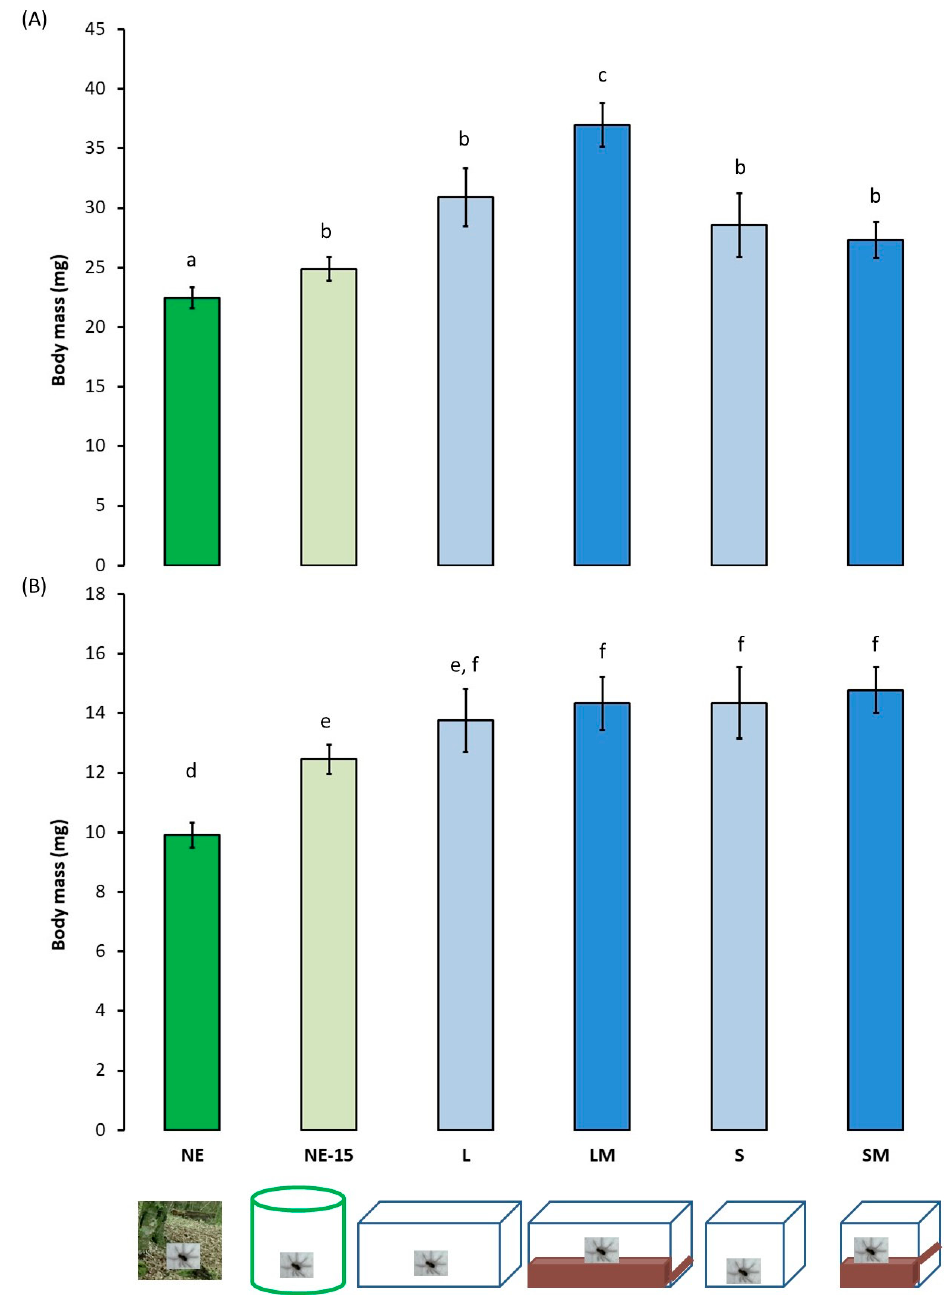
Figure 3. Body mass ±95% confidence intervals (in mg) of adult female ( A ) and male ( B ) Pardosa saltans in relation to the environment where they developed: in their natural environment and tested between 2 and 3 h after capture (NE); in their natural environment and tested after 15 days in captivity (NE-15); in the laboratory in large terraria without matter on the base (L); in the laboratory in large terraria with matter on the base (LM); in the laboratory in small terraria without matter on the base (S); in the laboratory in small terraria with matter on the base (SM). Data were compared using generalised linear mixed mod (GLMM, negative binomial distribution). Different letters indicate a significant difference at p < 0.050, post hoc Wald test.